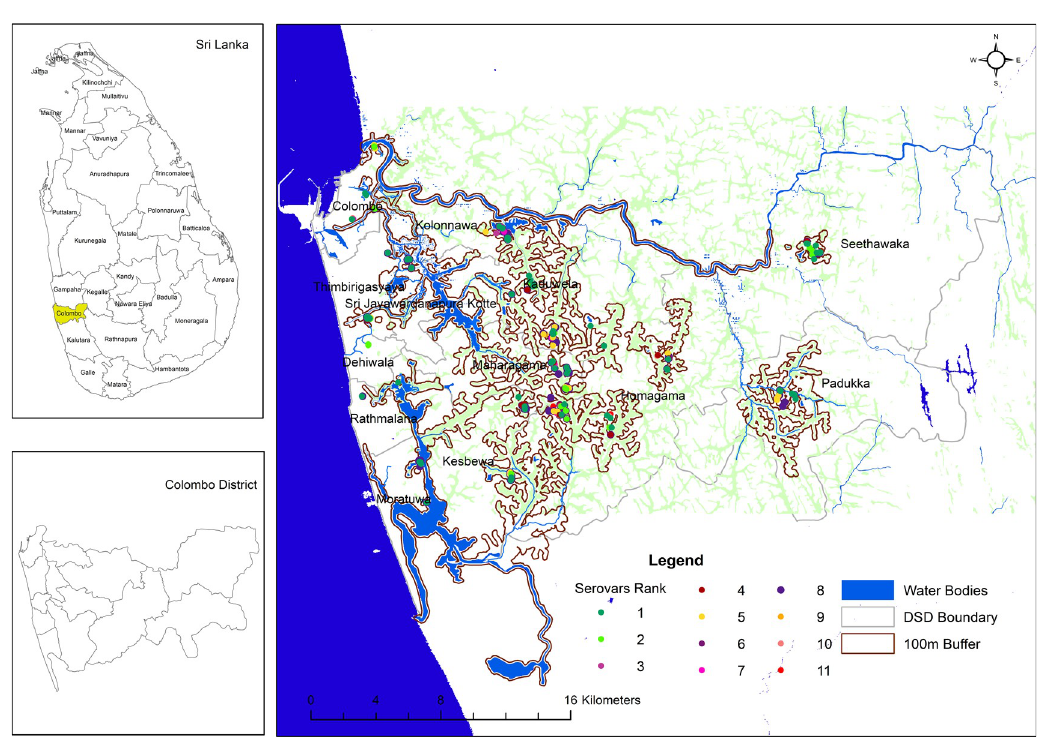
Fig 4. Pathogenic Serovar distribution among water bodies and paddy fields. Key to serovar numbers:1 –Australis, 2. Bankinang, 3 –Bataviae, 4 –Canicola, 5 –Ratnapura, 6—Hardjo, 7 –Icterohaemorrhagiae, 8 –Pyrogenes, 9 –Pomona, 10 – Hebdomadis, 11 –Cynopteri. Areas outlined in green indicates paddy fields and water tributaries. This image is licensed under the Creative Commons Attribution 4.0 International License (http://creativecommons.org/licenses/by/4.0/).